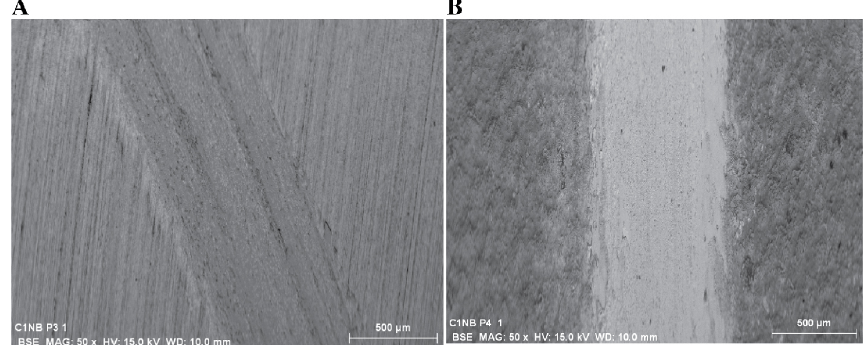
Figure 9: SEM micrograph of the wear track of grade (NB) WC-Co-5% TiC cermets after sliding against Al ing of the two temperatures: (A) P1(450°C) and (B) P2(650°C) after (5000 m) of sliding. SEM/EDS micrographs of the wear tracks of grade (NB) WC-Co-5% TiC cermets after sliding against